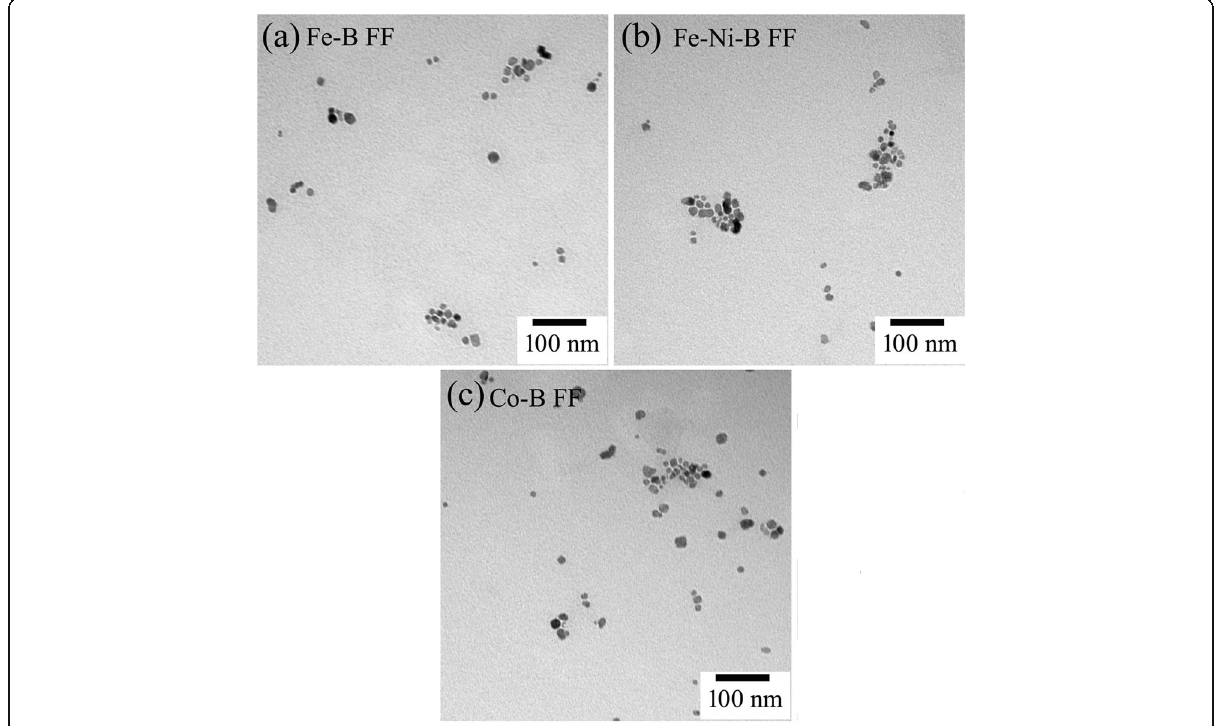
Fig. 4 TEM images of Fe-B FF ( a ), Fe-Ni-B FF ( b ), and Co-B FF ( c